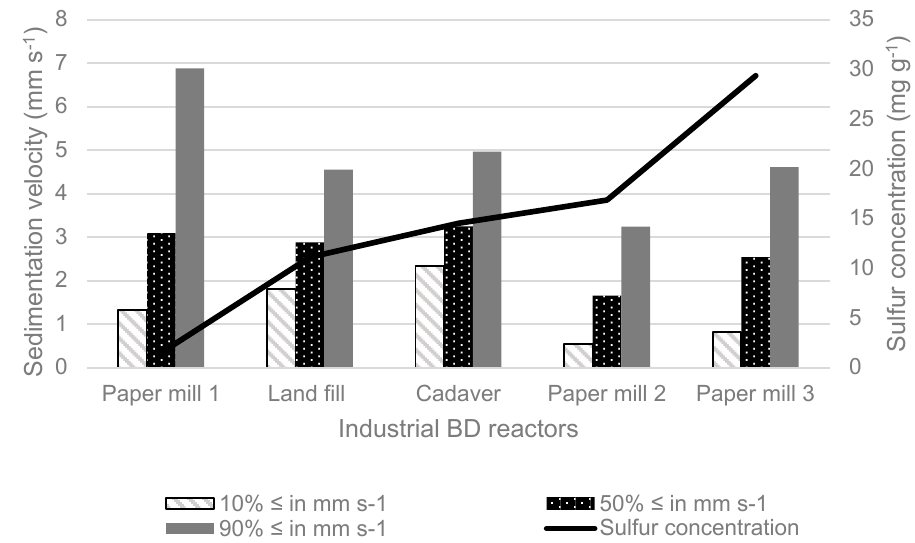
Figure 9. Sedimentation velocity at 725 × g as compared to sulfur concentration. A light trend shows that samples with high sulfur concentration have lower sedimentation velocity.